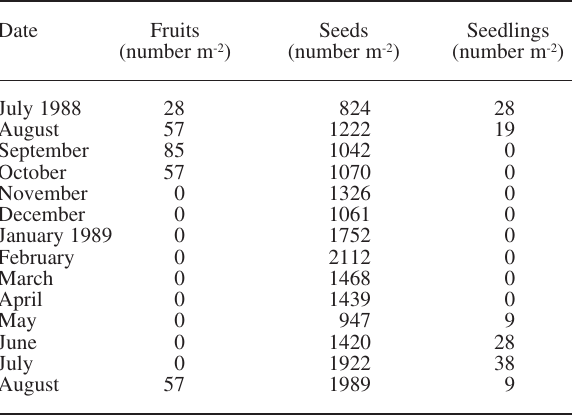
the second year (Fig. 5). The mean width of the differentiated and undif- ferentiated leaves showed a definite seasonal trend, with maximum values in August (3.6 ± 0.4 and 2.9 ± 0.3 mm respectively) (Fig. 6). A significant differ- ence was found between the two leaf ranks (K-W test = 31.16; P < 0.001).